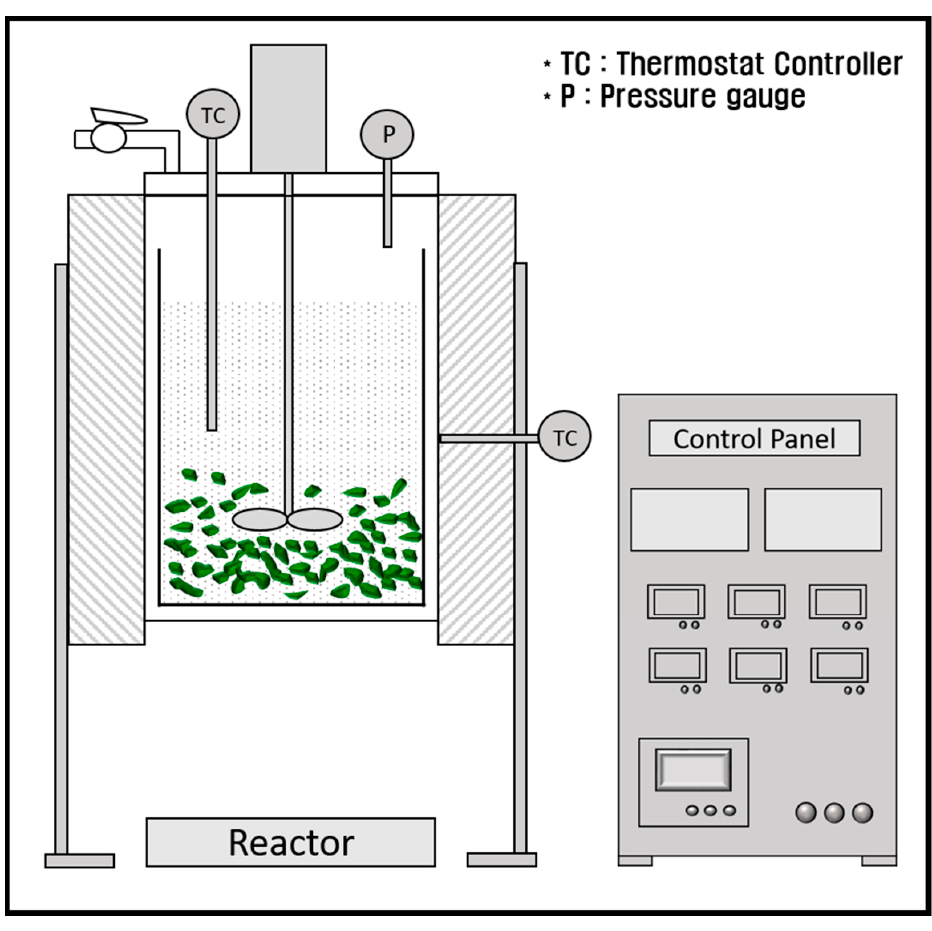
Figure 1. Schematic diagram of the wet torrefaction system.